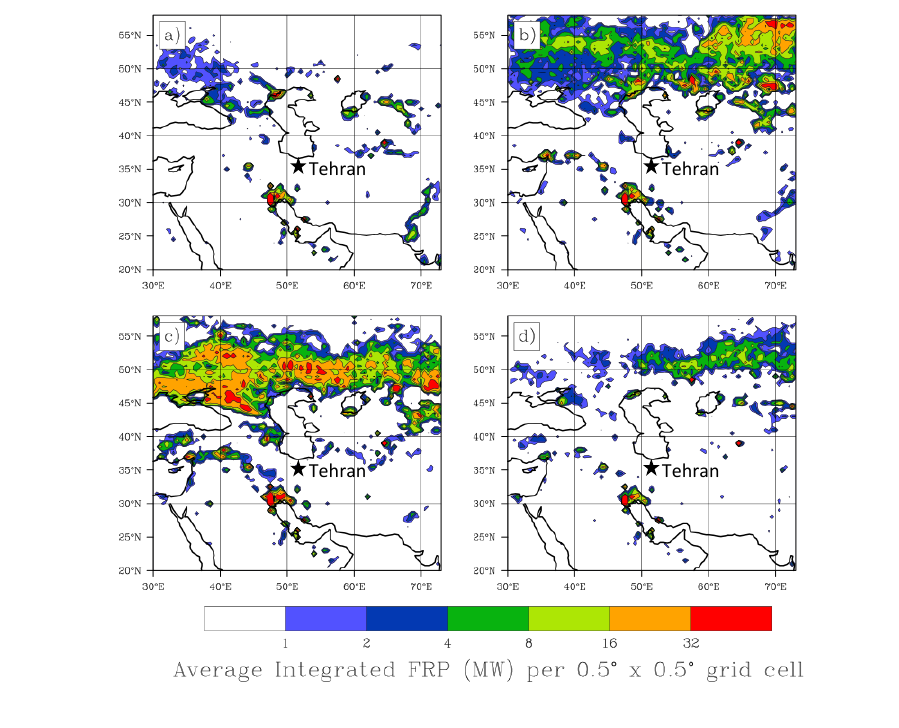
Figure 5. Seasonal patterns in Fire Radiative Power (FRP) derived from Moderate Resolution Imaging Spectroradiometer (MODIS) Fire Information for Resource Management System (FIRMS) data from 2000 to 2009. FRP is shown as integrated seasonal average power (megawatts per 0.5° × 0.5° grid box) for ( a ) winter